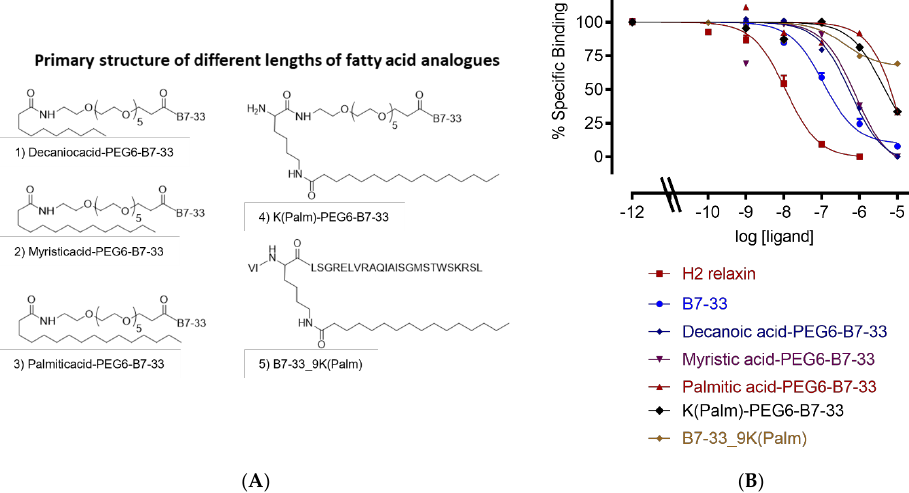
Figure 2. Primary structure and sequence of lipidated analogues. ( A ) Different lengths of fatty acids: ( 1) decanoic acid (C10), ( 2) myristic acid (C14), ( 3) palmitic acid (C16), ( 4) lysine palmitic acid (C16), and ( 5) lysine replaced with lysine palmitic acid at 9th position of B7-33. ( B ) Eu-H2 relaxin competition binding of lipidated analogues in HEK-7BP cells. The data are the result of n = 3–4 independent experiments and expressed as mean ± SEM. Table 1. List of analogues and their binding affinities (pKi) in HEK-7BP cells, BSA free assay .